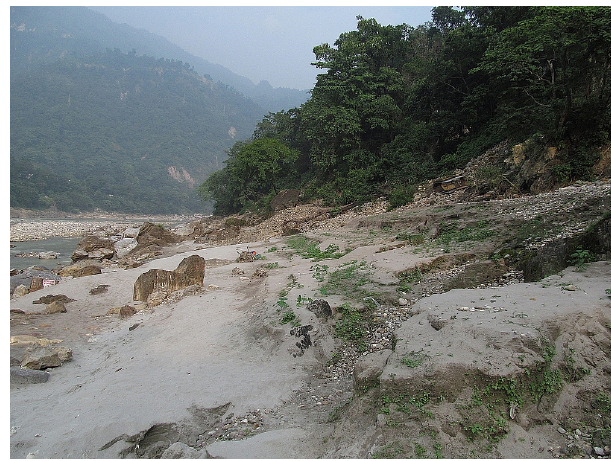
Figure A8. RFLO – sand flood deposit associated with 2013 Alak- nanda flooding; ∼ 7m above water level in October